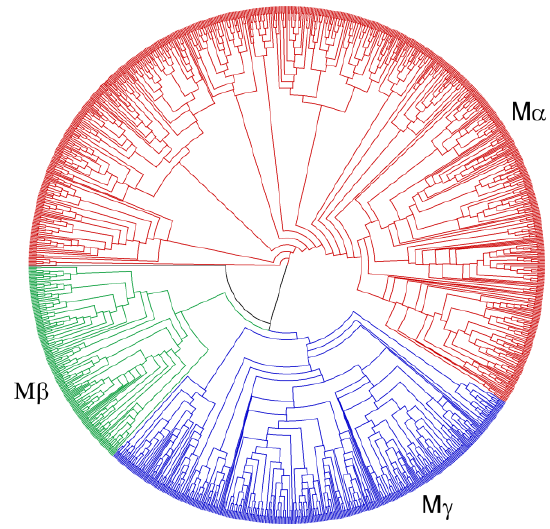
Figure 5. Phylogeny of Type II MADS-box genes from 24 plant species including known genes from A. thaliana , P. trichocarpa , G. max , C. sativus , O. sativa , S. moellendorffii ,